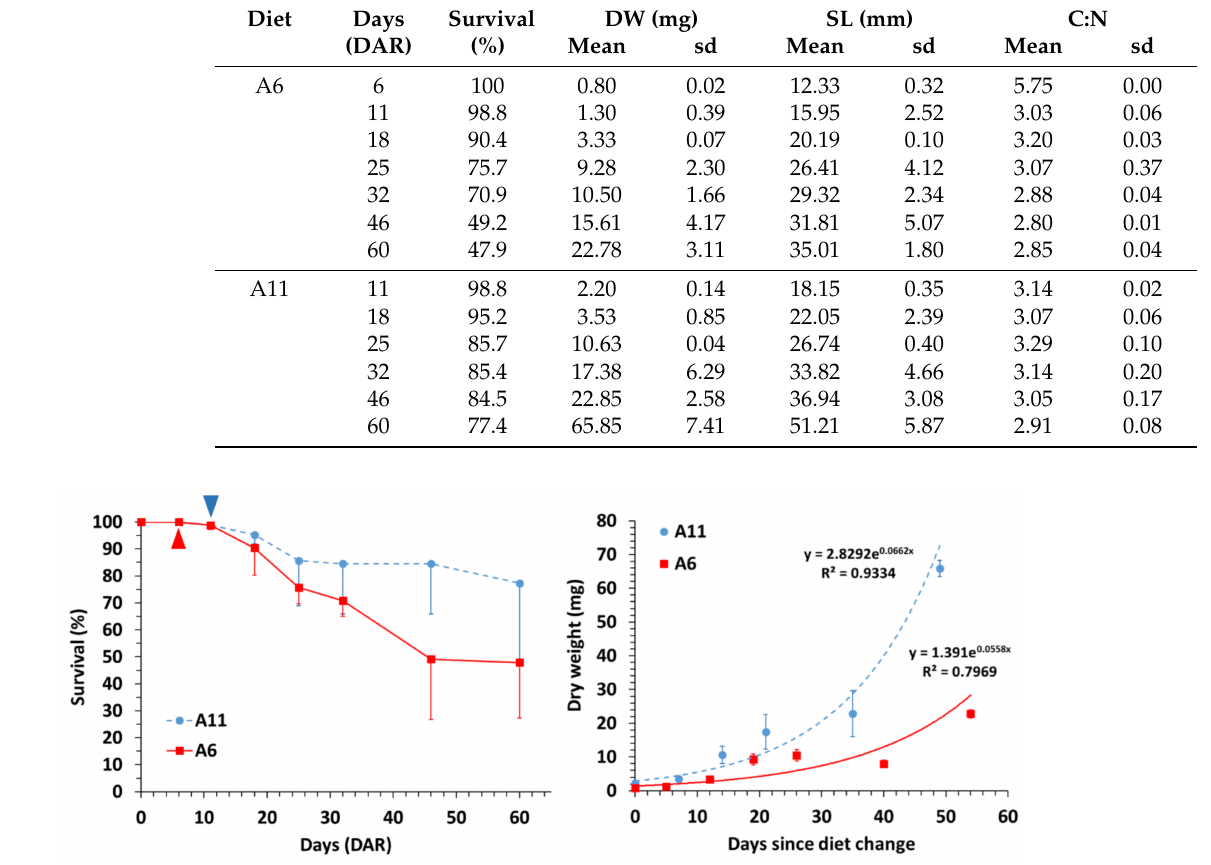
Table 1. Survival, dry weight (DW), standard length (SL), and C:N ratios during the experimental period in Hippocampus reidi juveniles submitted to dietary treatments A6 and A11. Data are provided as means (two batches per diet) and standard deviations (sd).